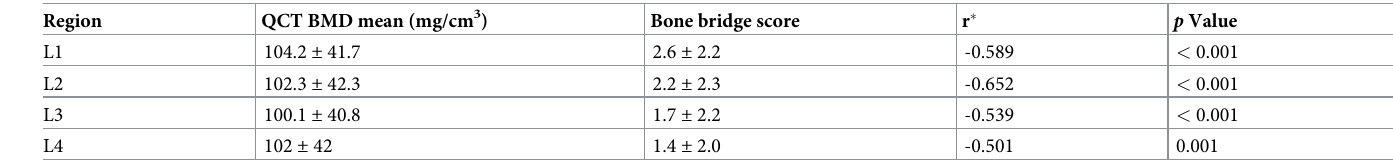
Table 2. Correlation between bone bridge and QCT